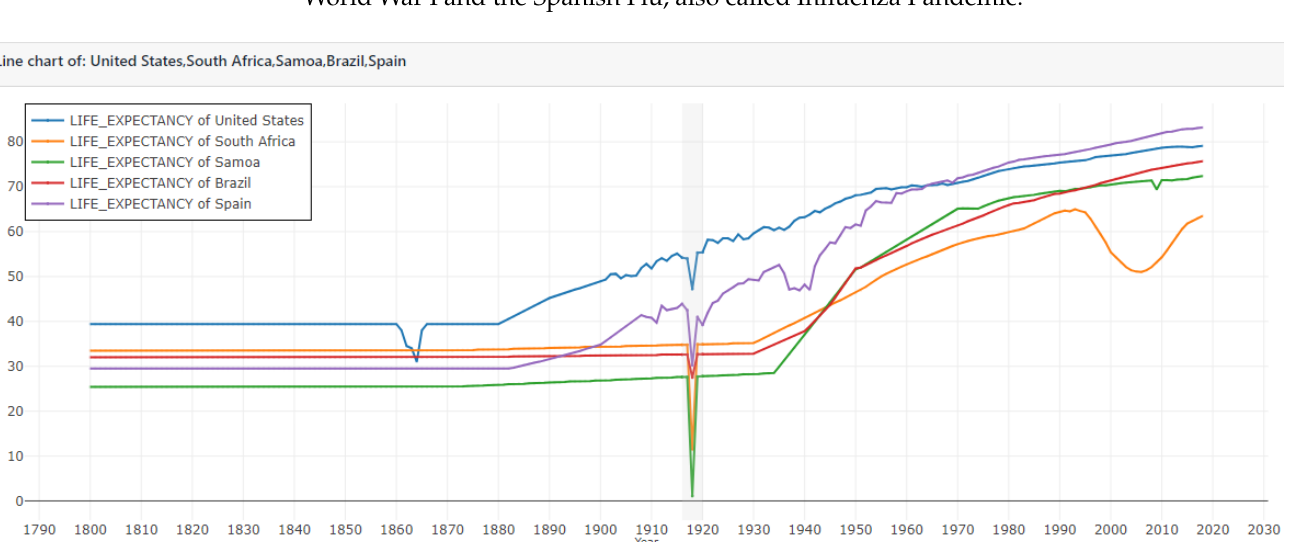
Figure 6. Life expectancy line chart multiple countries. All countries present the same valley between 1917 and 1919, indicating a global reason for the drop in life